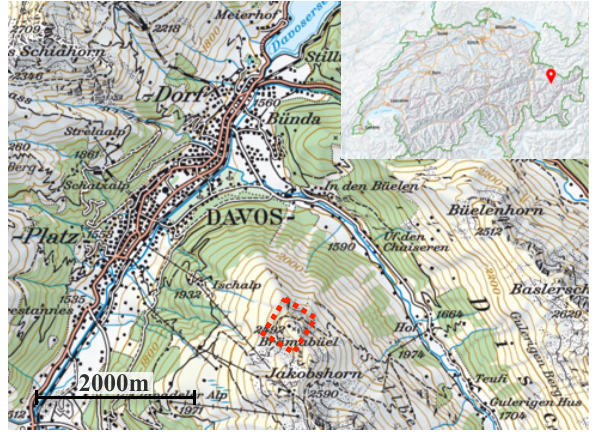
Figure 2. Shaded UAV DSM "Brämabühl" with reference points